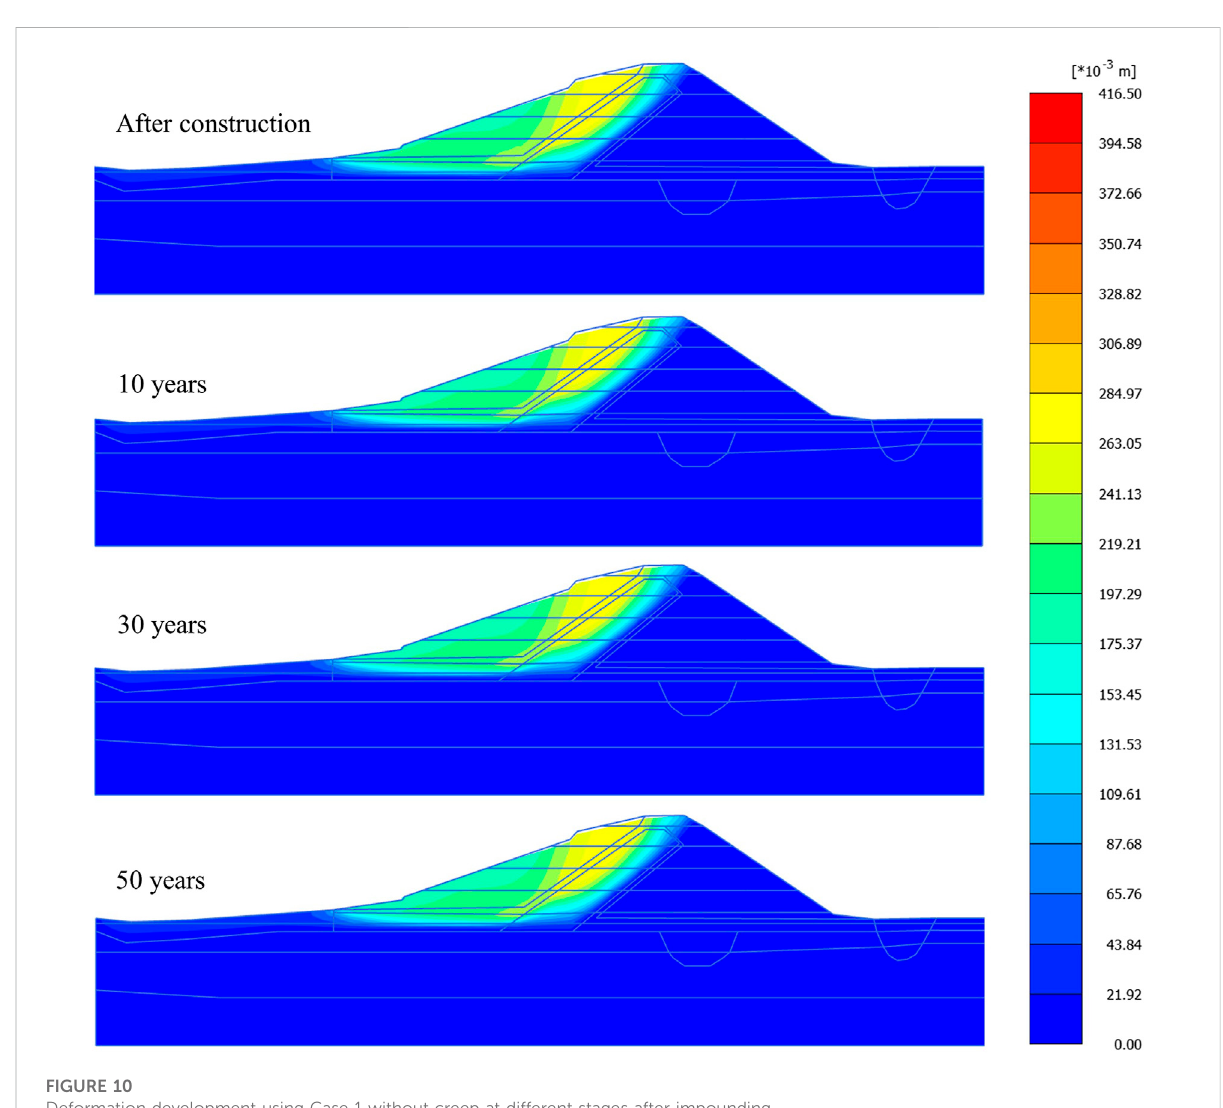
FIGURE 10 Deformation development using Case 1 without creep at different stages after